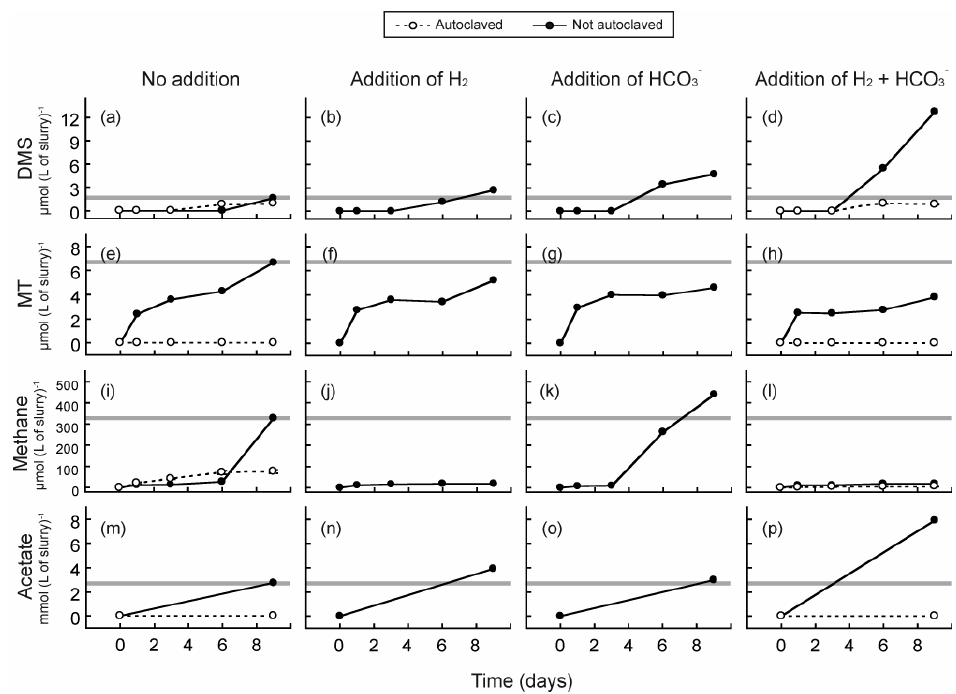
Fig. 2. 2 Fig. 2. Effects of H 2 and bicarbonate on the formation of dimethyl sulfide (DMS), methanethiol (MT), methane, and acetate in the sediment slurries of Lake Plußsee. Gray lines mark the final concentration of each compound in parallel with the concentration when no substrate was added. Data are from a single sample tube but the pattern is reproducible in similar